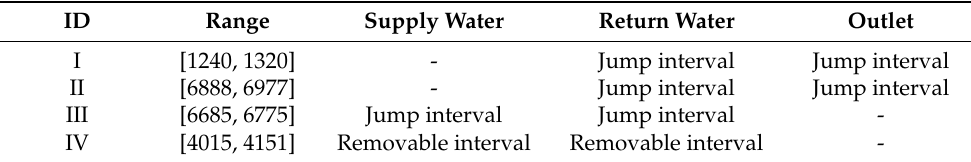
Table 6. The long interval classification of flow